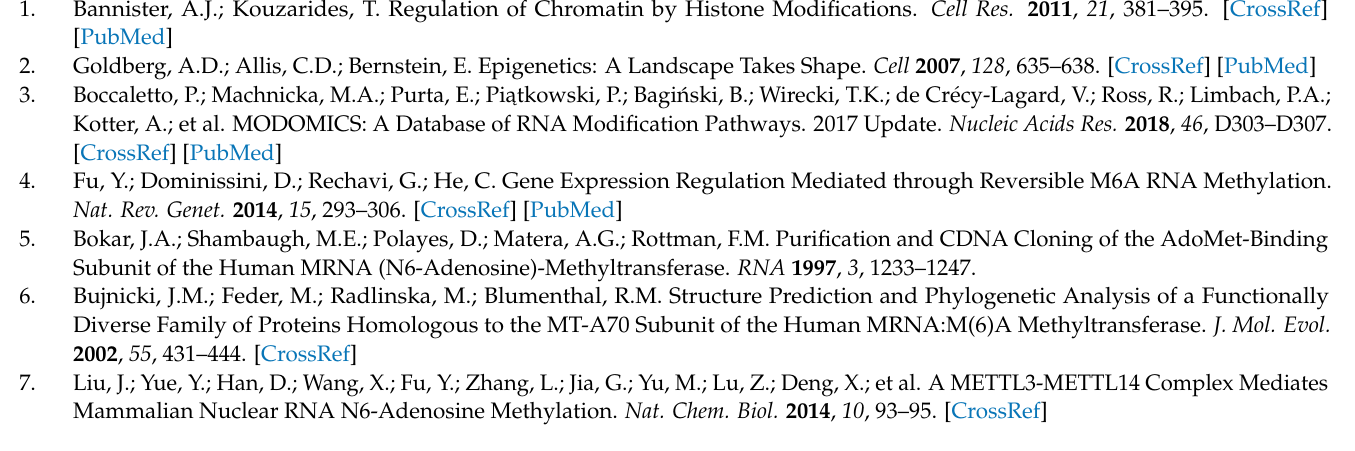
FvYTH proteins. Figure S2: Phylogenetic analysis of YTHs in strawberry and humans. Figure S3: Sequence alignments YTHDFs in strawberry and humans. Figure S4: Sequence alignments YTHDCs in strawberry and humans. Figure S5: The expression trends of FvYTH genes in different development stages. Figure S6: The bias in composition of the N terminal of FvYTH proteins compared with all strawberry proteins. Table S1: The identification of FvYTH genes in strawberry. Table S2: The properties of YTH proteins. Table S3: The synteny relationships between forest strawberry and Arabidopsis. Table S4: The sequences of YTH domain from strawberry, rice, Arabidopsis. Table S5: The identification of cis-elements in the promoters of FvYTH genes. Table S6: The CDS sequences of FvYTH